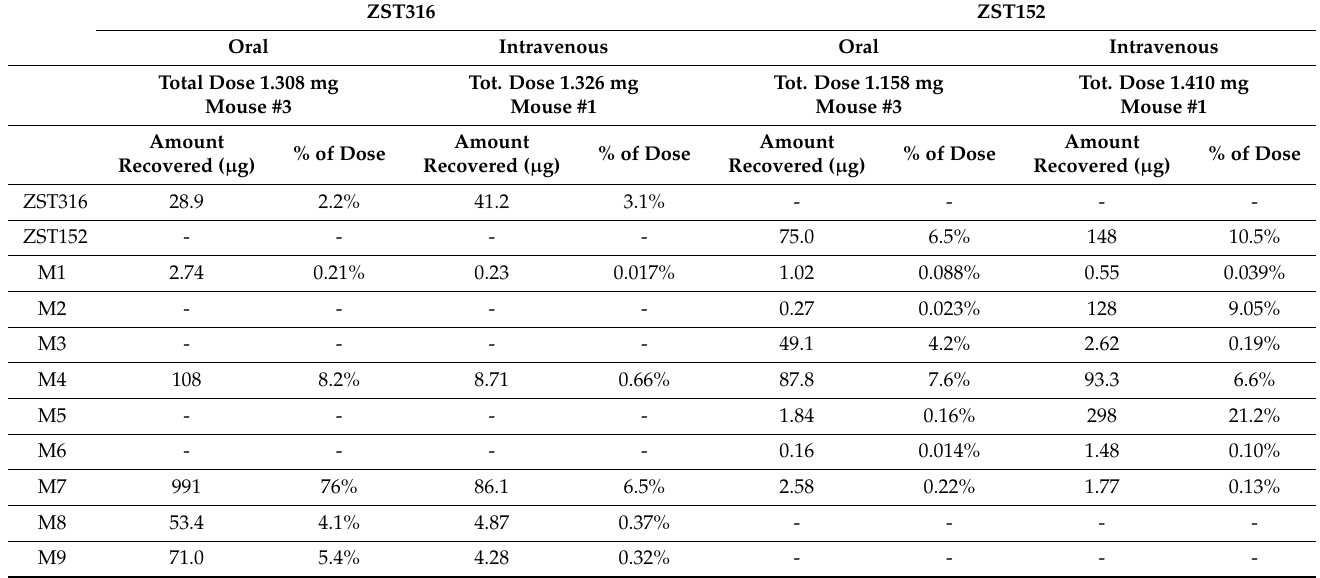
Table 7. List of supposed metabolites (M) for ZST316 and ZST152 found in urine after oral and intravenous administration with quantification by HPLC MS/MS expressed as relative abundance to parent